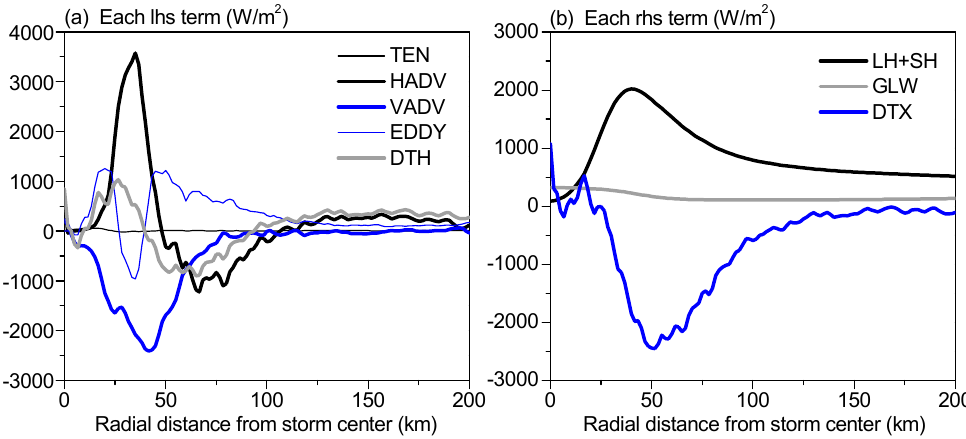
Figure 7. Radial distributions of ( a ) lhs and ( b ) rhs terms comprising boundary-layer MSE budget averaged between 108 and 120 h. Vertical integral is taken from the surface to 1 km altitude.